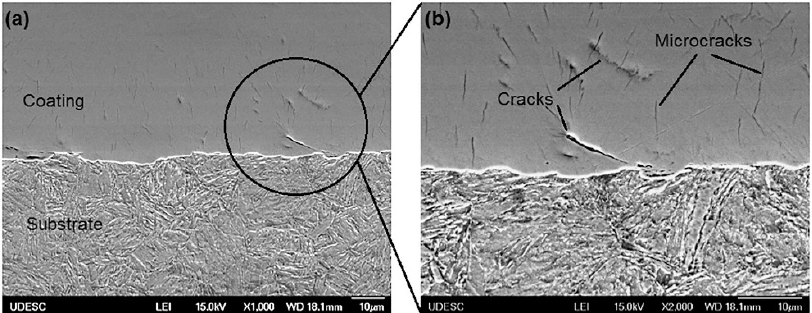
Figure 1. Cross sectional micrograph of hard chrome coated specimen showing; ( a ) coating overview; and ( b ) detail of the black circle shown in ( a ) [41]. Reprinted with permission from [41]. © 2018 SciELO.